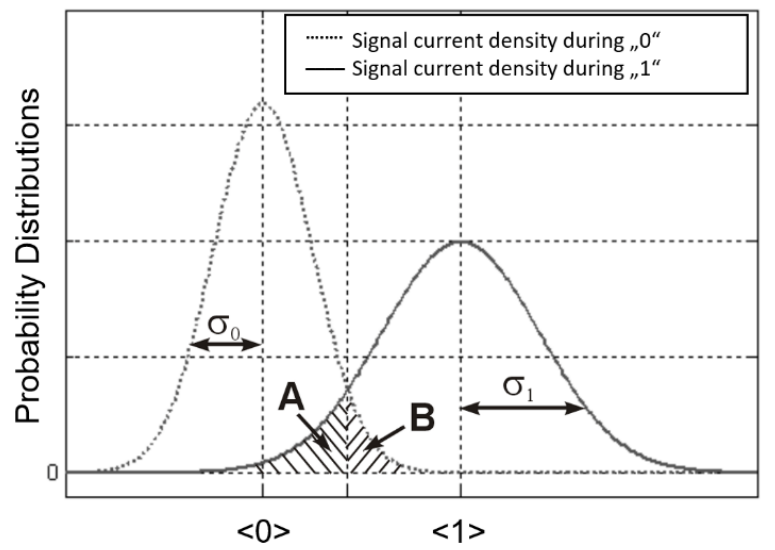
Figure 7. Generic situation of the Gaussian-shaped noise distributions at binary 1 and 0. The areas on the wrong side of I Thr are minimized with an optimum decision threshold level. For an analytically applicable approximation, I Thr is defined by the intersection of both curves, which leads